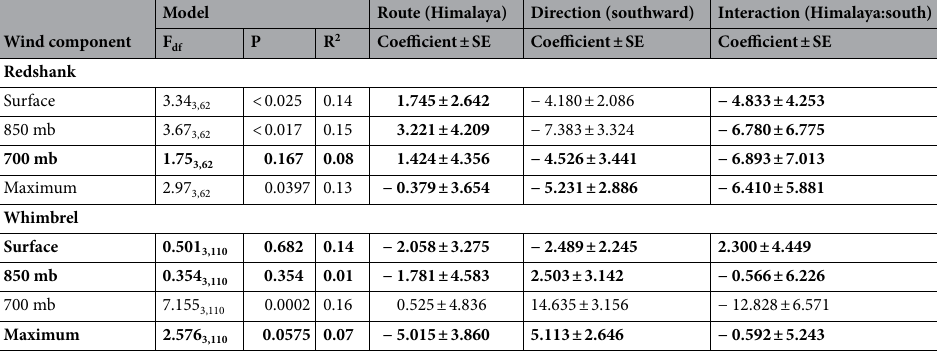
Table 5. Variation in wind support with migration route and direction for Common Redshanks and Whimbrels. Statistics are from linear regressions of wind support in relation to route × direction. Overall model statistics are provided, along with the coefficients for factors. Coefficients represent the change in wind support in km h −1 when moving from eastern (reference) to Himalayan routes or from northward (reference) to southward migrations. Non-significant models or coefficients are shown in bold.